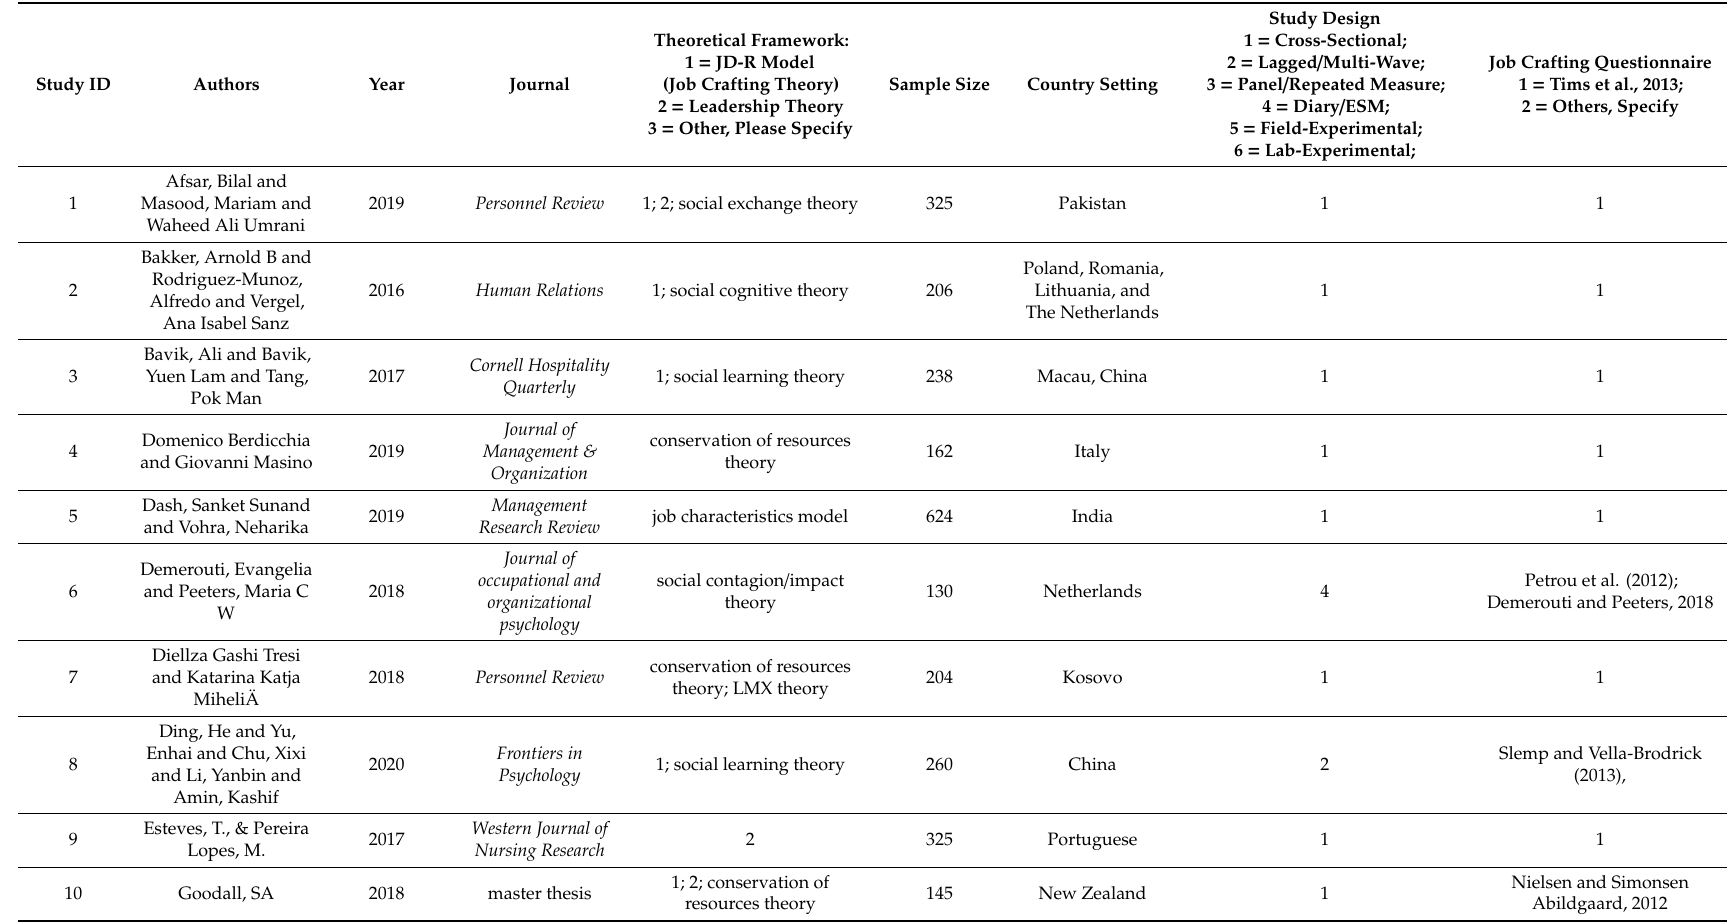
Table A1. A summary of selected studies in this